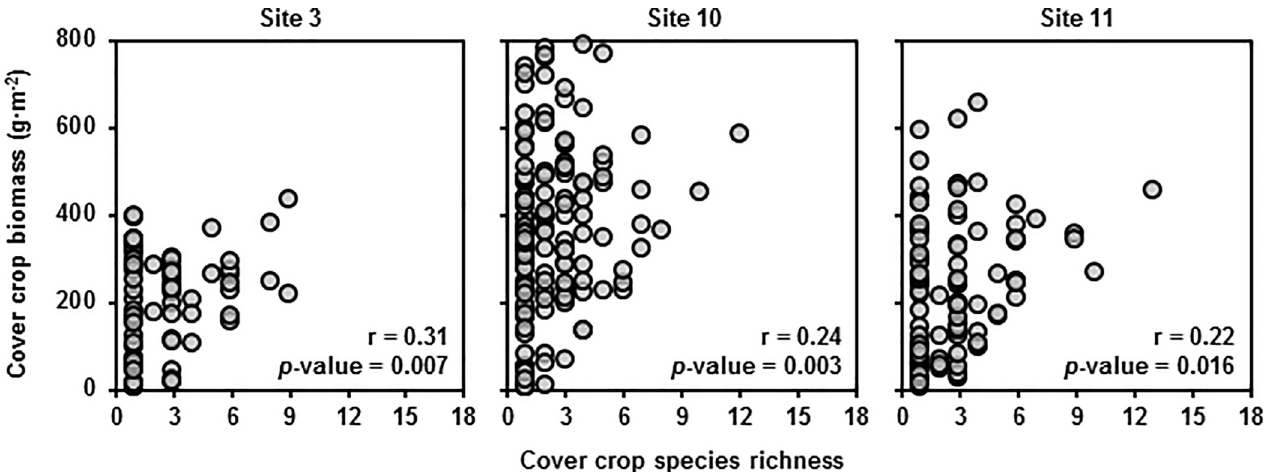
Fig 6. Cover crop biomass on species richness. Cover crop biomass versus realized cover crop species richness with Pearson correlation coefficients (r) for each site. Three data points with cover crop biomass beyond 1000 g m -2 not shown. P -values are for the following hypothesis test regarding the correlation coefficients—H 0 : r = 0; H a : r 6¼ 0.